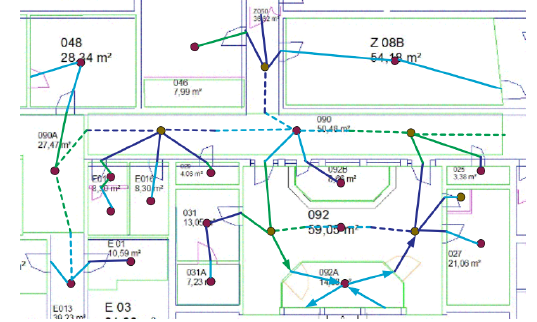
Figure 2. Comparison of S-MAT and door-to-door route (Liu & Zlatanova,